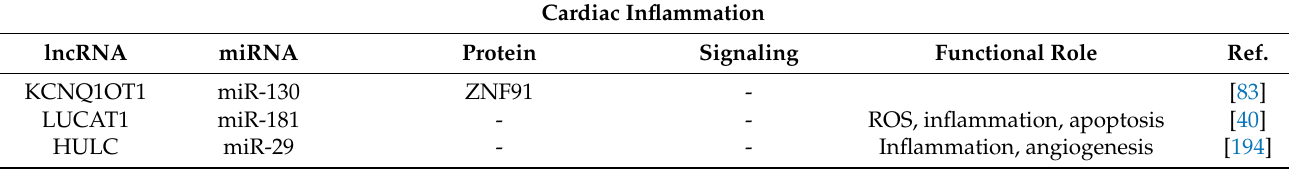
Table 1. List of lncRNAs and their corresponding sponged microRNAs affecting distinct proteins and signaling pathways. Highlighted ncRNAs and proteins (in bold) correspond to those lncRNAs and proteins with which they have been reported to physically interact, i.e., by means of pull-down assays. Cardiac Inflammation Signaling Functional